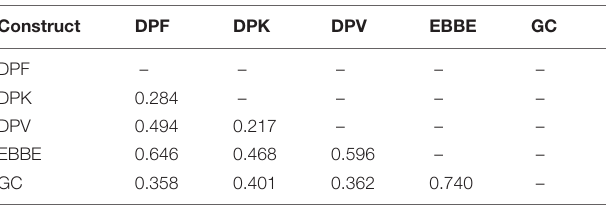
TABLE 3 | Discriminant validity (HTMT).